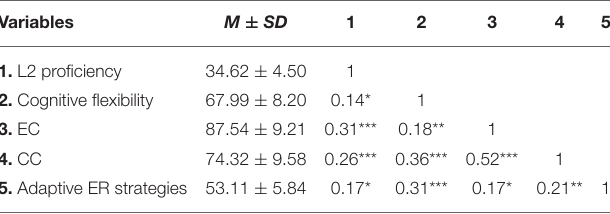
TABLE 1 | Means, standard deviations, and correlations between variables.